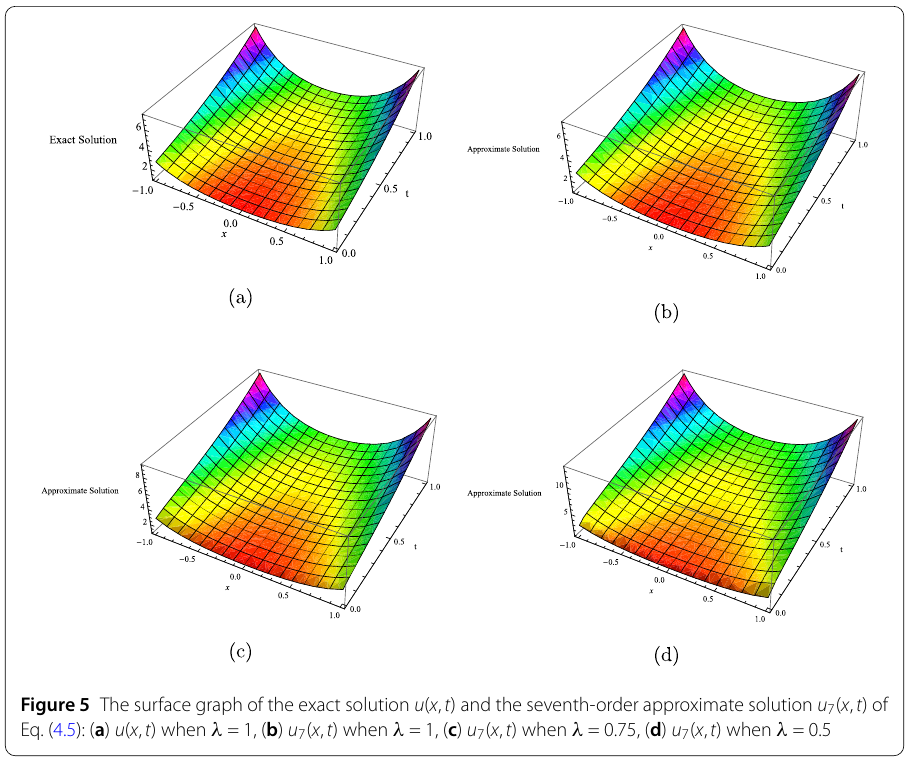
Figure 5 The surface graph of the exact solution u ( x , t ) and the seventh-order approximate solution u 7 ( x , t ) of Eq. (4.5): ( a ) u ( x , t ) when λ = 1, ( b ) u 7 ( x , t ) when λ = 1, ( c ) u 7 ( x , t ) when λ = 0.75, ( d ) u 7 ( x , t ) when λ = 0.5